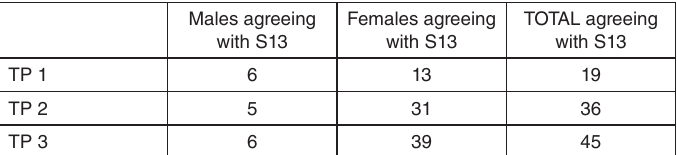
Table 5: Agreement with S13, ‘ I am passionate about global education ’ by gender at time points 1, 2, and 3 Males agreeing Females agreeing TOTAL agreeing with S13 with S13 with S13 TP 1